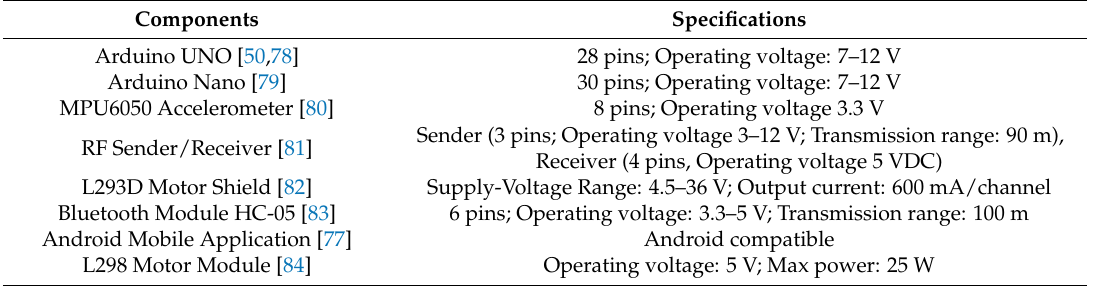
Table 1. Specification of electronic components used in to design the proposed system.